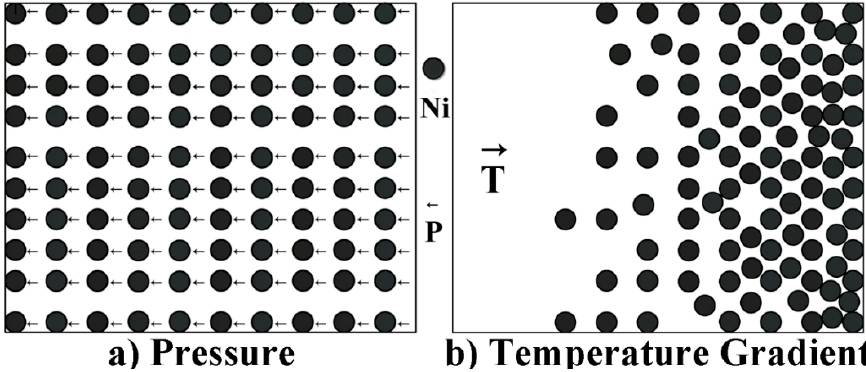
Figure 6. Schematic diagram of the Ni atoms diffusion in the mushy zone. ( a ) high pressure; ( b ) ambient pressure.